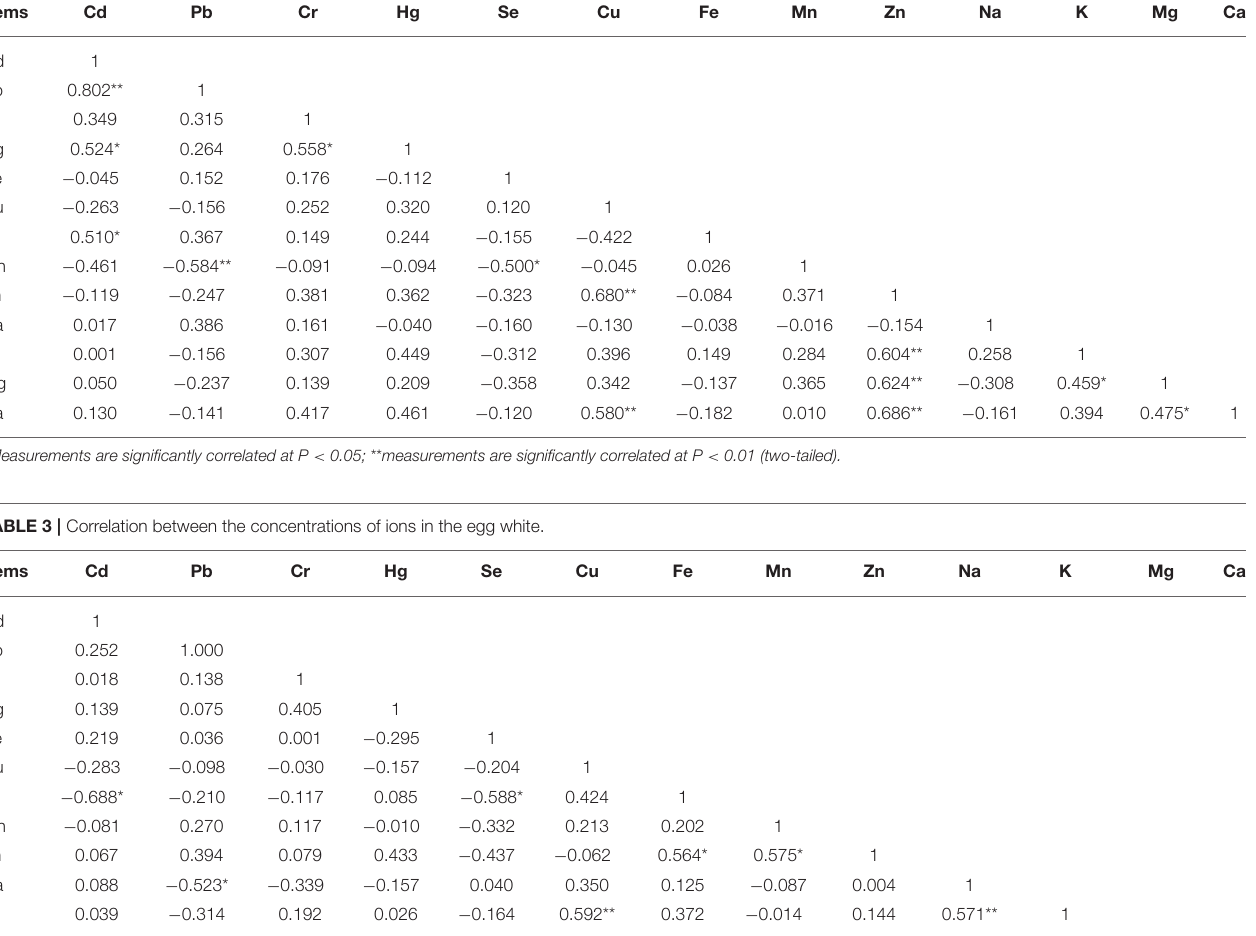
TABLE 2 | Correlation between the concentrations of ions in the egg yolk. Items